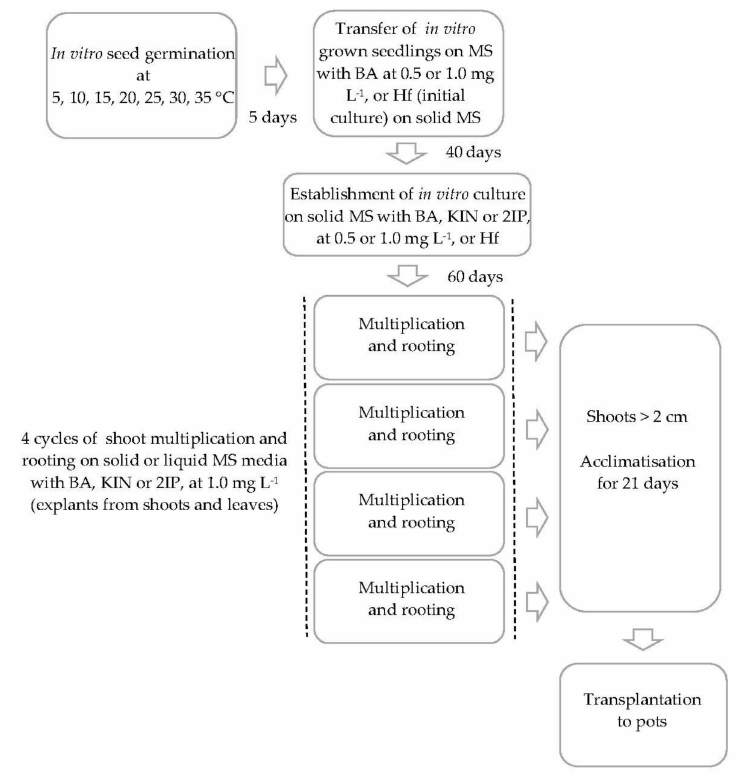
Figure 1. Schematic representation of Dyckia brevifolia in vitro propagation procedures starting from in vitro germinated